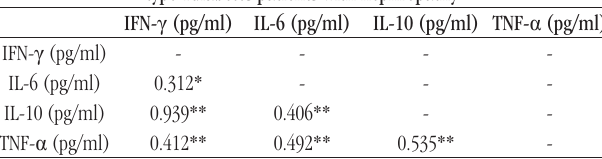
taBLE 5 − Correlation among inflammatory cytokines in type 1diabetes patients with